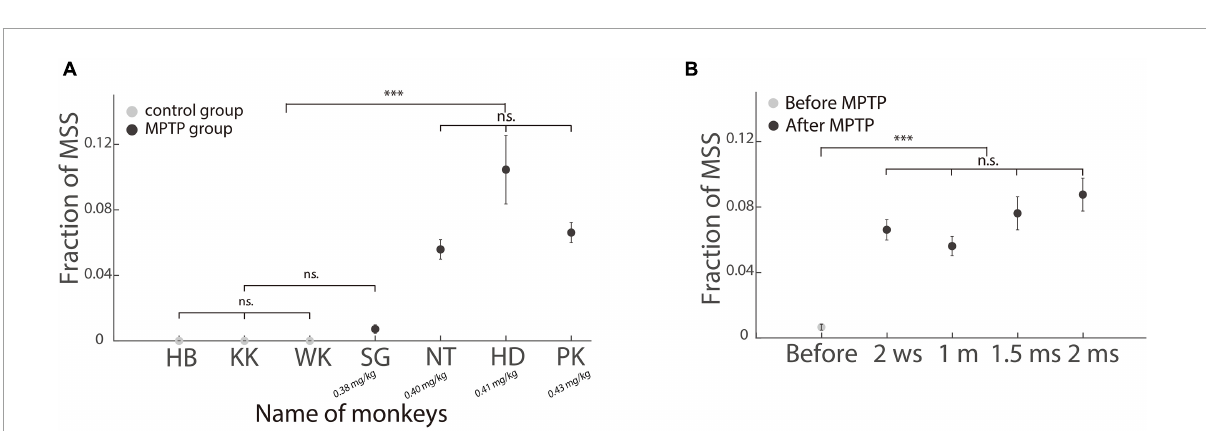
FIGURE6 Incidence of MSS in healthy and subclinical hemi-PD monkeys. (A) Comparing the incidence of MSS between healthy and subclinical hemi-PD monkeys. The incidence of MSS was significantly higher in the three hemi-PD monkeys with MPTP dose larger than 0.4 mg/kg. Please be aware that the dosage of MPTP increases from left to right. (B) The incidence of MSS before and after MPTP injection in one hemi-PD monkey (PK). The X -axis is the time (w: week, m: month). The incidence of MSS increased significantly after MPTP injection. Error bars show the standard error of the mean; ∗∗∗ p < 0.0001, n.s., no significant difference (Wilcoxon rank-sum test).